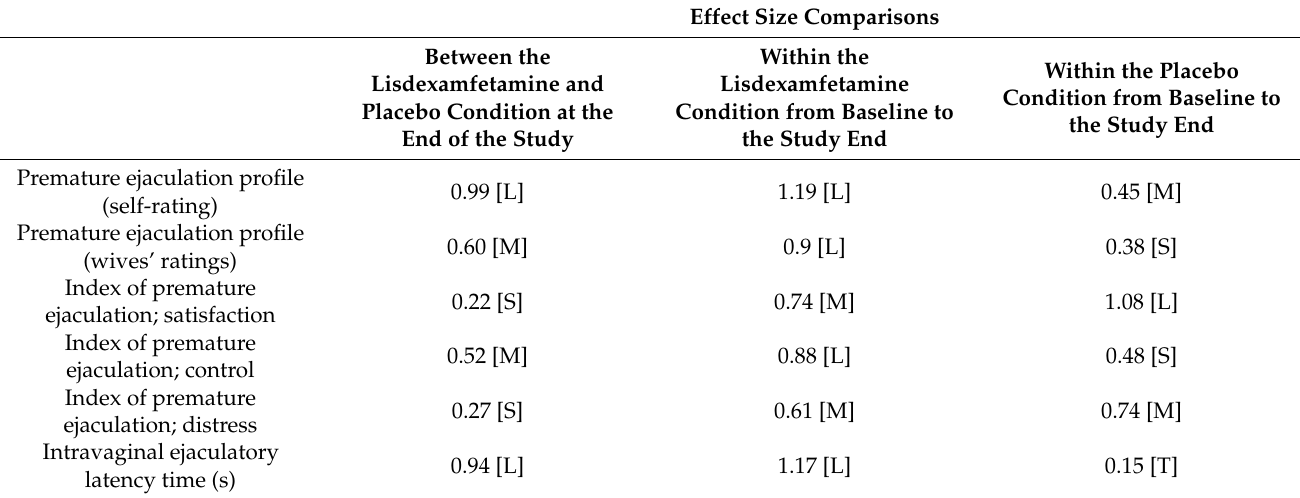
Table 4. Overview of effect sizes; between group comparison at the end of the study; within group comparison from baseline to the end of the